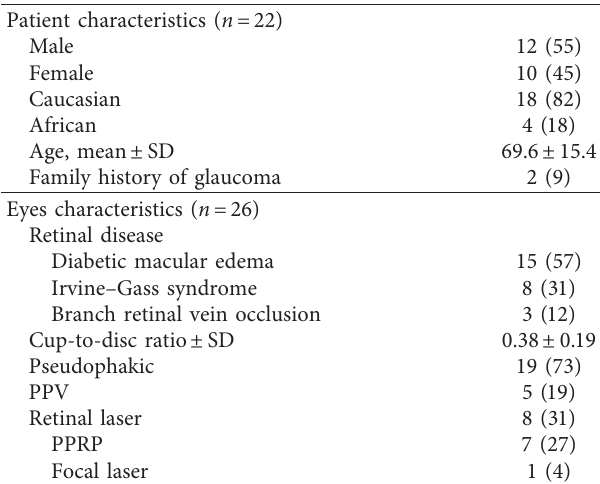
Table 1: Baseline demographic characteristics of the 22 patients who underwent SLT after DEX-implant injection.